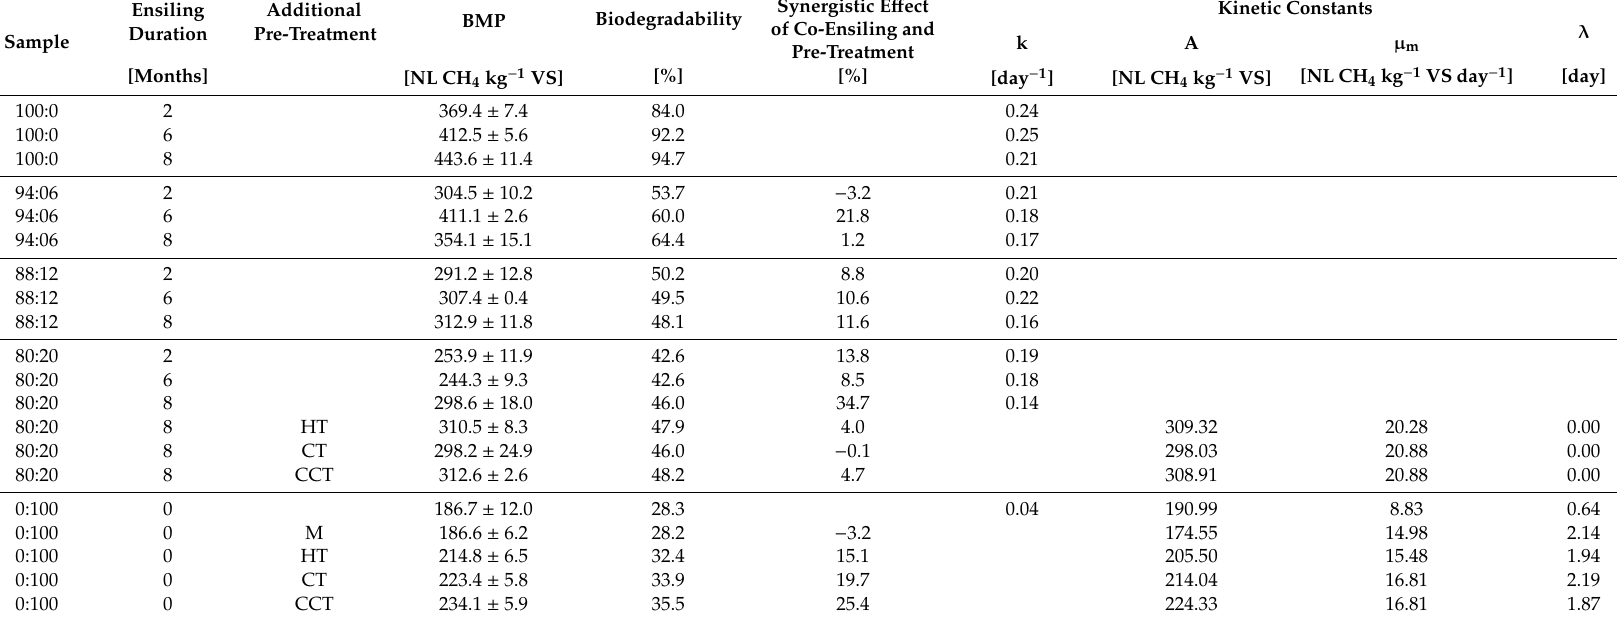
Table 4. Methane yield, biodegradability and kinetic constants for ensiled and pre-treated samples with a mixing ratio (wet weight based) of sugar beet root and wheat straw at 100:0, 94:6, 88:12, 80:20 and 0:100 at di ff erent ensiling